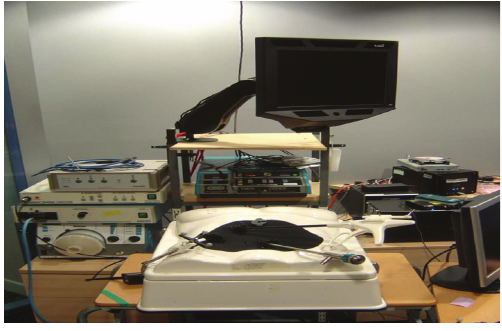
Figure 3: Traditional box [19, 20]. Table 1: Course programme.